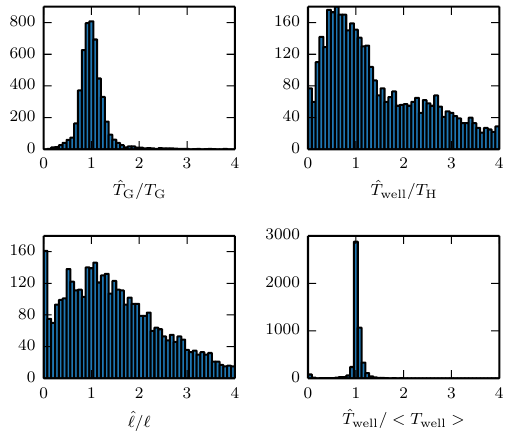
Figure 4. Histogram on the best-fitting estimates ( ˆ T G , ˆ T well , ˆ (cid:96) ) ver- sus the theoretical input values ( T G , T H , (cid:96) ) and the sampled trans- missivity at the pumping well ( < T well > ) for the N = 5000 real- izations of ensemble